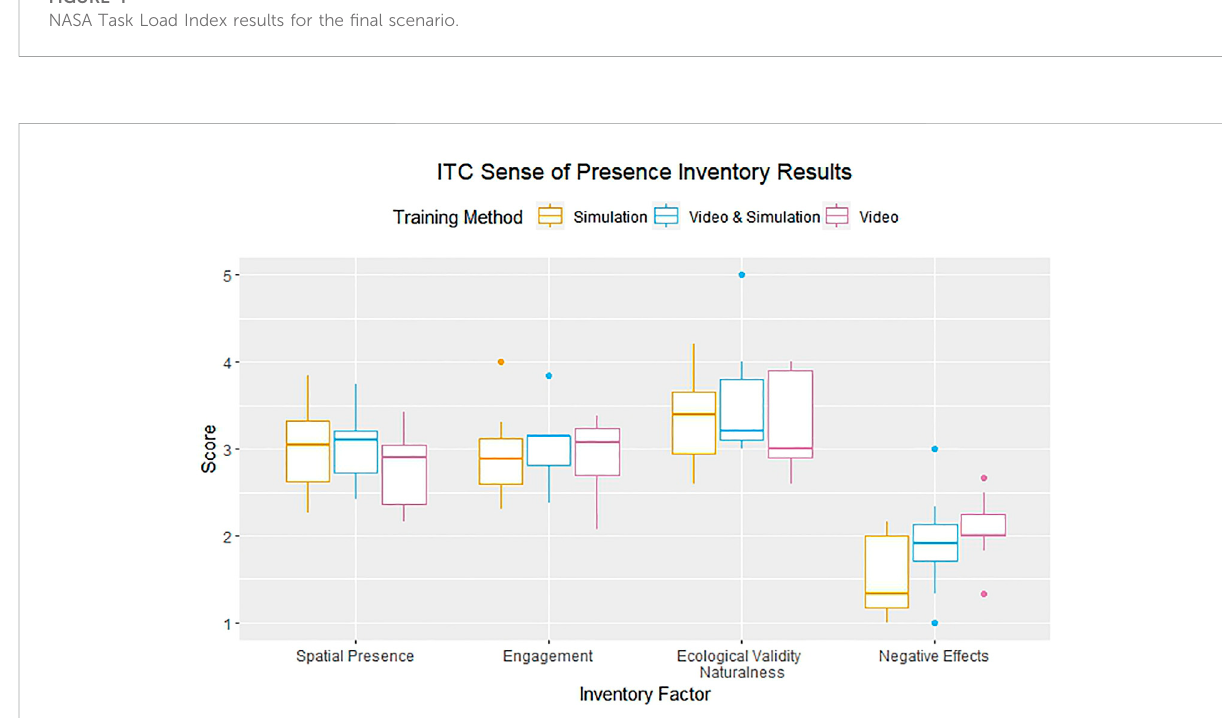
FIGURE 5 ITC Sense of Presence Inventory Factors grouped by training